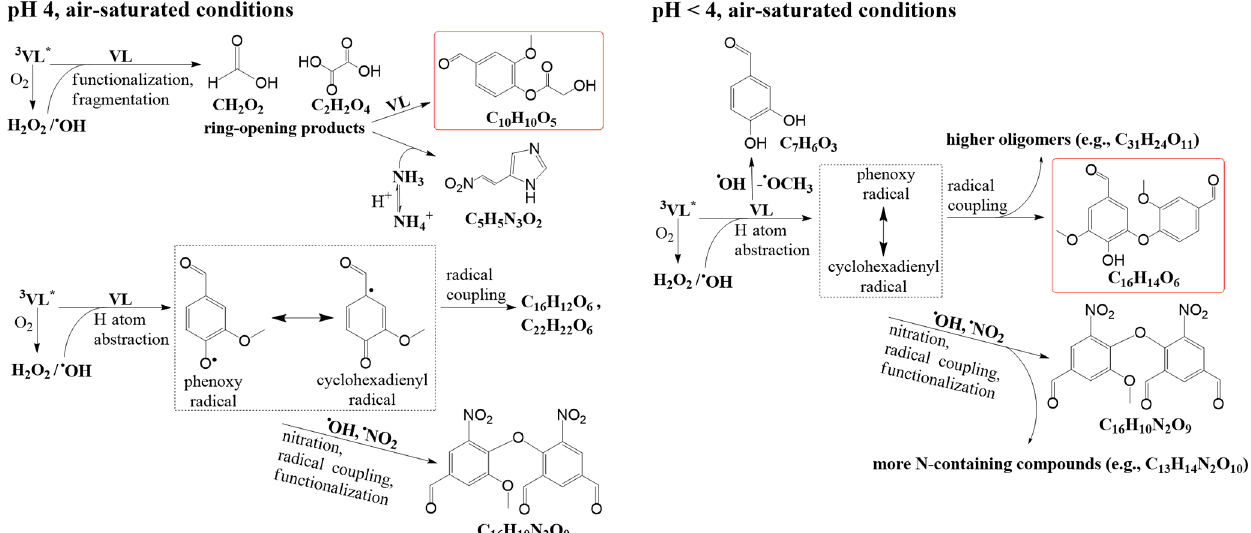
Figure 2. Potential aqSOA formation pathways via the direct photosensitized oxidation of VL in the absence (VL ∗ ) and presence of am- monium nitrate (VL + AN) at pH 4 and pH < 4 under air-saturated conditions. Product structures were proposed based on the molecular formulas, double bond equivalent (DBE) values, and MS / MS fragmentation patterns. The structures presented were the major products detected using UHPLC-qToF-MS in positive ESI mode. The highlighted structures are the most abundant product for each